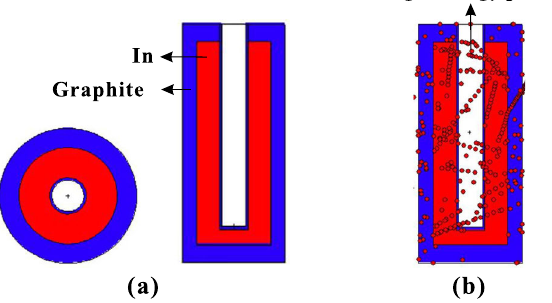
Fig. 2 Simulation model: a prone and orthophoto of geometric model; b transport diagram of particles in the model